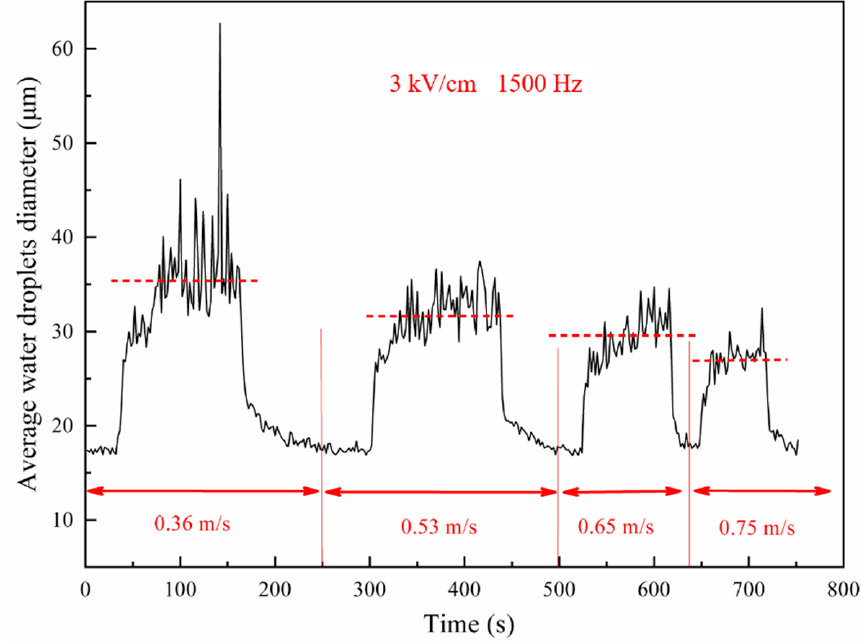
Figure 22. Variations of average water droplet size under different fluid velocities.